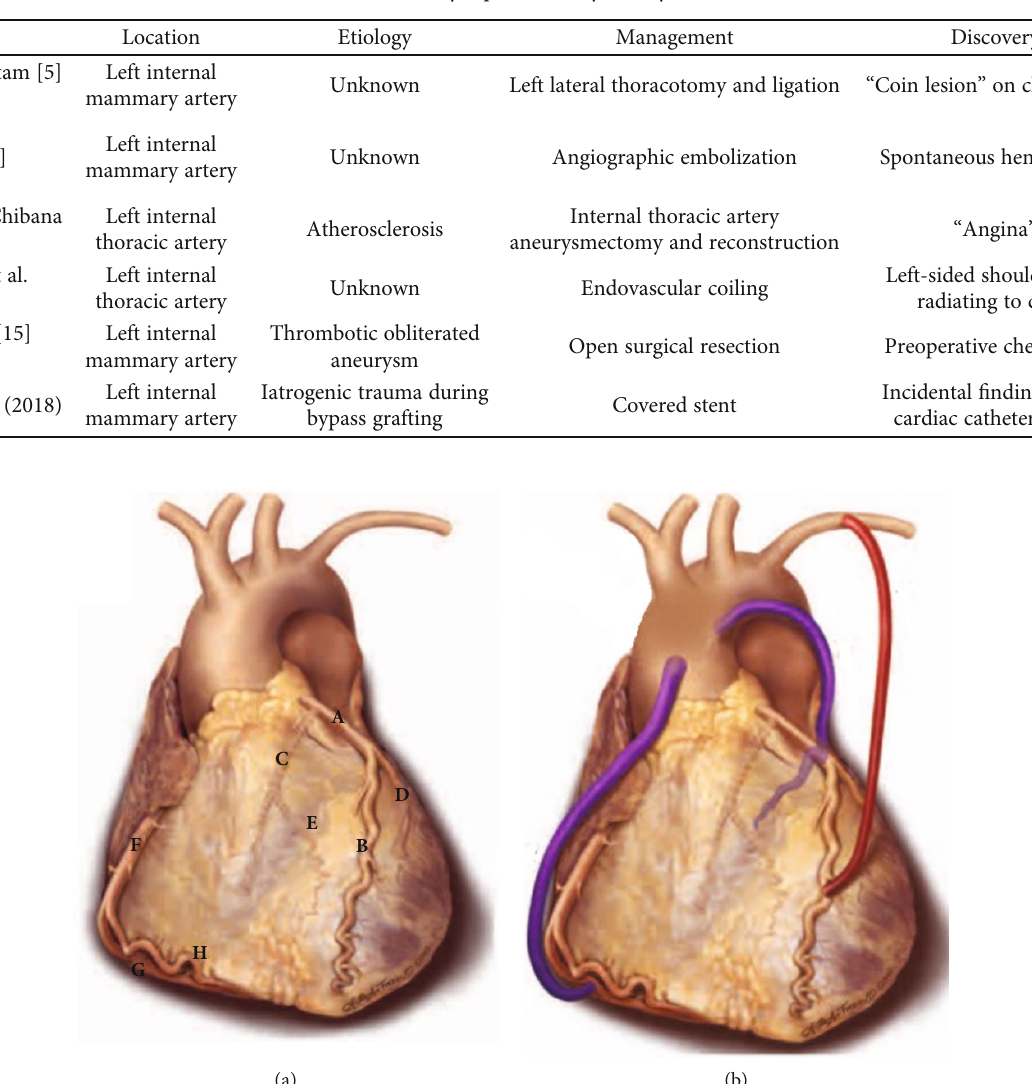
Table 1: Previously reported artery aneurysms [8].